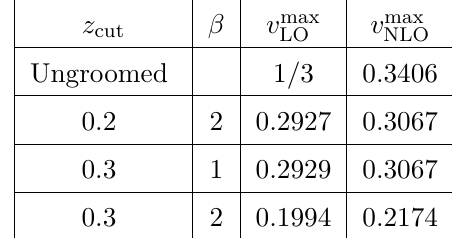
Table 2 . Table of transverse thrust end-point values determined numerically at LO and NLO. The kinematical end-points for the β, z cut values not shown are unaltered by grooming. τ SD = v SD . Both parts are regularised using Catani-Seymour dipole subtraction [71, ⊥